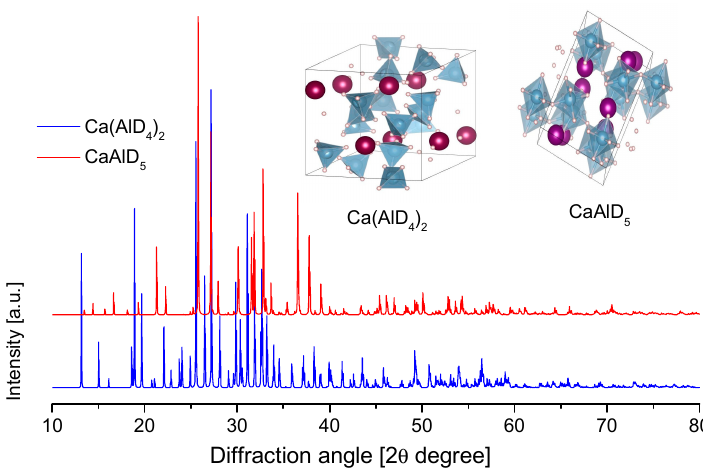
Figure 15. Crystal structure of calcium alanates and their calculated diffraction patterns ( λ = Cu k α 1 ).